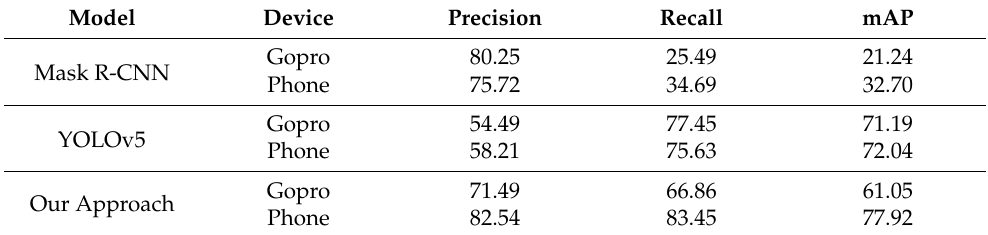
Table 6. Results of training and testing images from same devices.